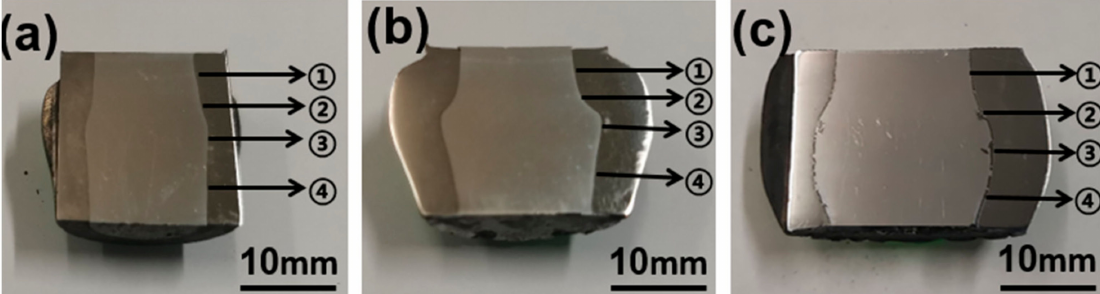
Figure 11. Measurement positions of the gears under different degrees of deformation: ( a ) 50%, ( b ) 70%, ( c ) 90%.